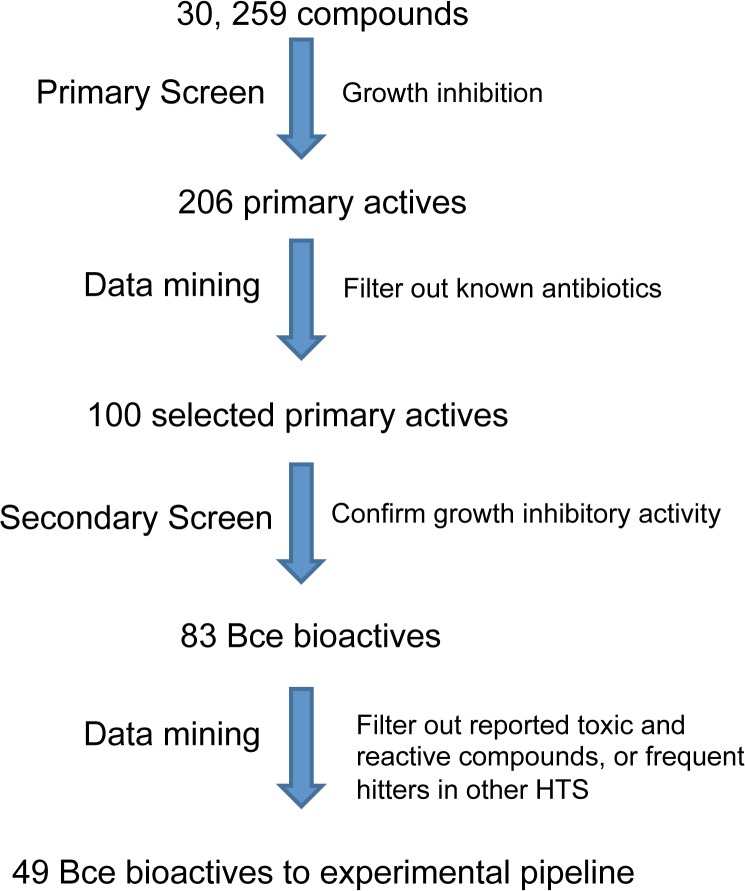
High throughput screening and compound prioritization process.Steps are shown as arrows with the name of the step to the left and the selection method to the right.